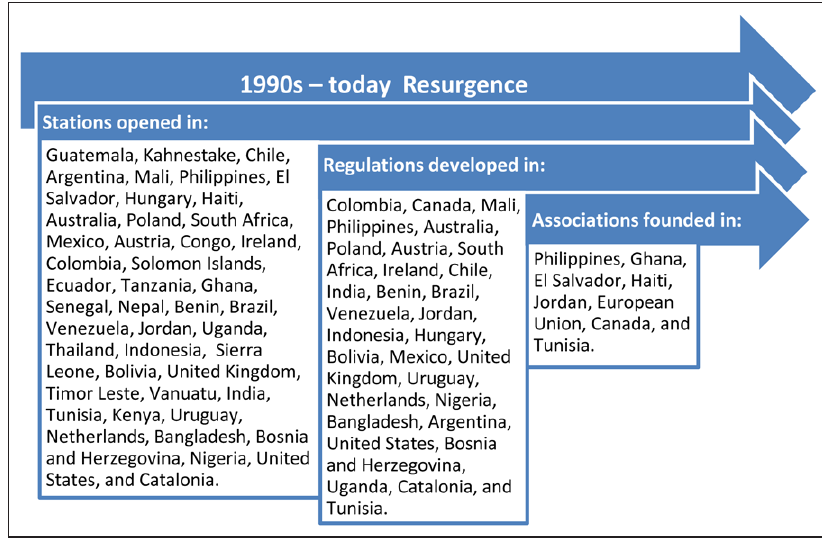
Figure 5: Resurgence period of community radio